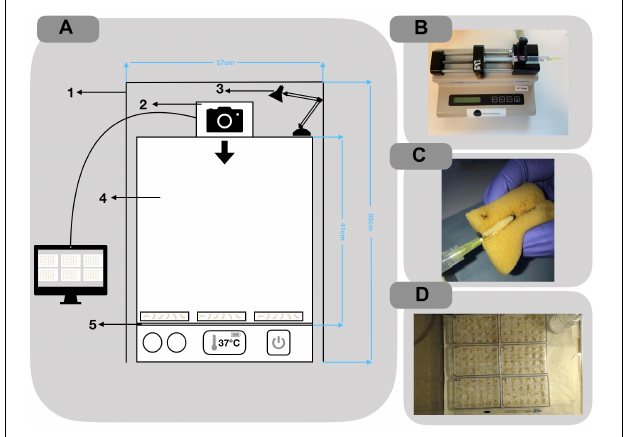
FIGURE 2 | (A) Schematic of the imaging setup used to record time-lapse photography of larvae 1: Black felt shroud to reduce the effects of natural light on quality of images; 2: Camera: Logitek C100 5 mp; 3: table lamp for consistent lighting; 4: perspex incubator: Stuart Scientific SI140; 5: Greaseproof paper for better contrast in images. (B) Automated syringe pump setup used for inoculating larva. (C) Injections were administered through the rear pro-leg. (D) Example of image output from SkyStudio Pro time-lapse software.